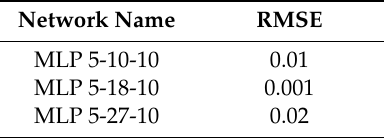
Table 6. Root Mean Square Error (RMSE) values for three MLP neural